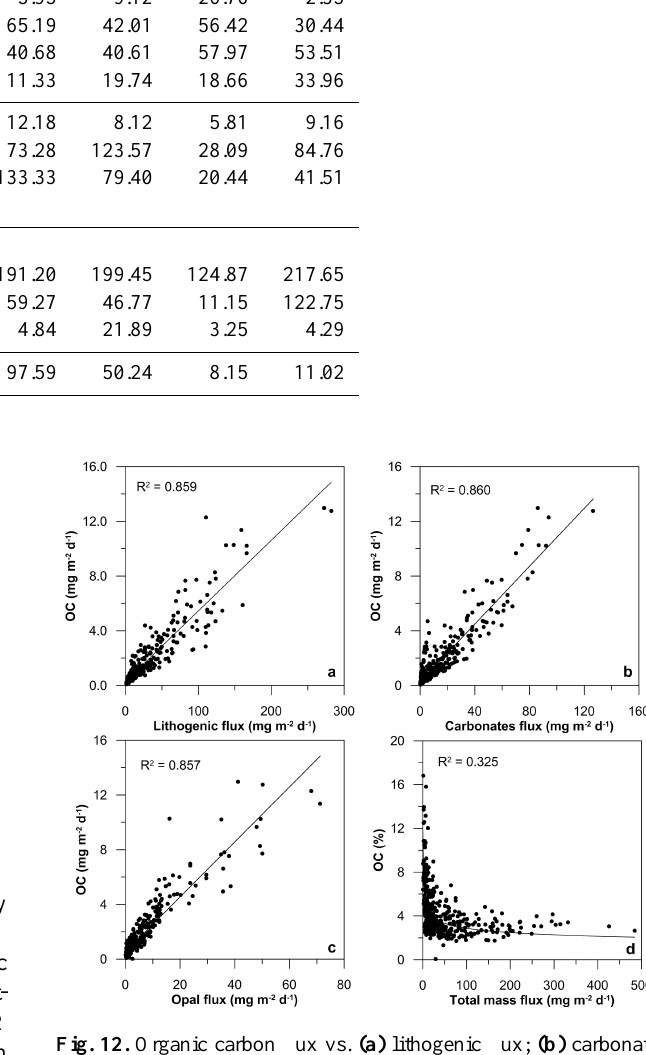
Fig. 12. Organic carbon flux vs. (a) lithogenic flux; (b) carbonate flux; (c) opal flux; and (d) organic carbon content vs. total mass